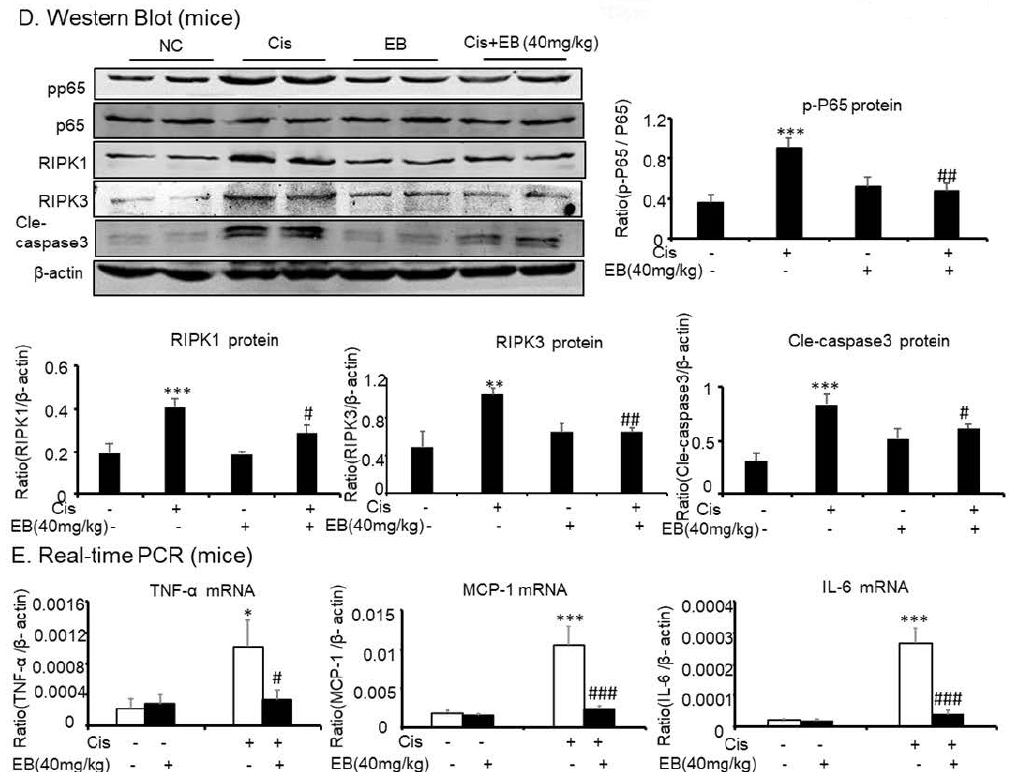
Figure 5. Eleutheroside B attenuated cisplatin-induced renal injury, inflammation, programmed necrosis, and apoptosis in vivo. ( A ) Western blot and real-time PCR analysis of KIM-1. ( B ) and ( C ) Immunohistochemistry of KIM-1 and TNF- α . IHC result and quantitative data indicate that treatment of eleutheroside B reduced the percentage of KIM-1 and TNF- α in injured kidney. ( D ) Western blot analysis and quantitative data of RIPK1, RIPK3, p-P65, and cle-caspase-3. ( E ) Real-time PCR of inflammation indexes. Real-time PCR demonstrate that treatment of eleutheroside B largely blocked upregulated mRNA levels of MCP-1, TNF- α , and IL-6 in cisplatin-injured kidney. * p < 0.05, ** p < 0.01, ** p < 0.001 compared to normal; # p < 0.05, ## p < 0.01, ### p < 0.001 compared to model. Cis, cisplatin; EB, eleutheroside B (40 mg / kg). KIM-1: kidney injury molecule-1. Magnification, 20 ×